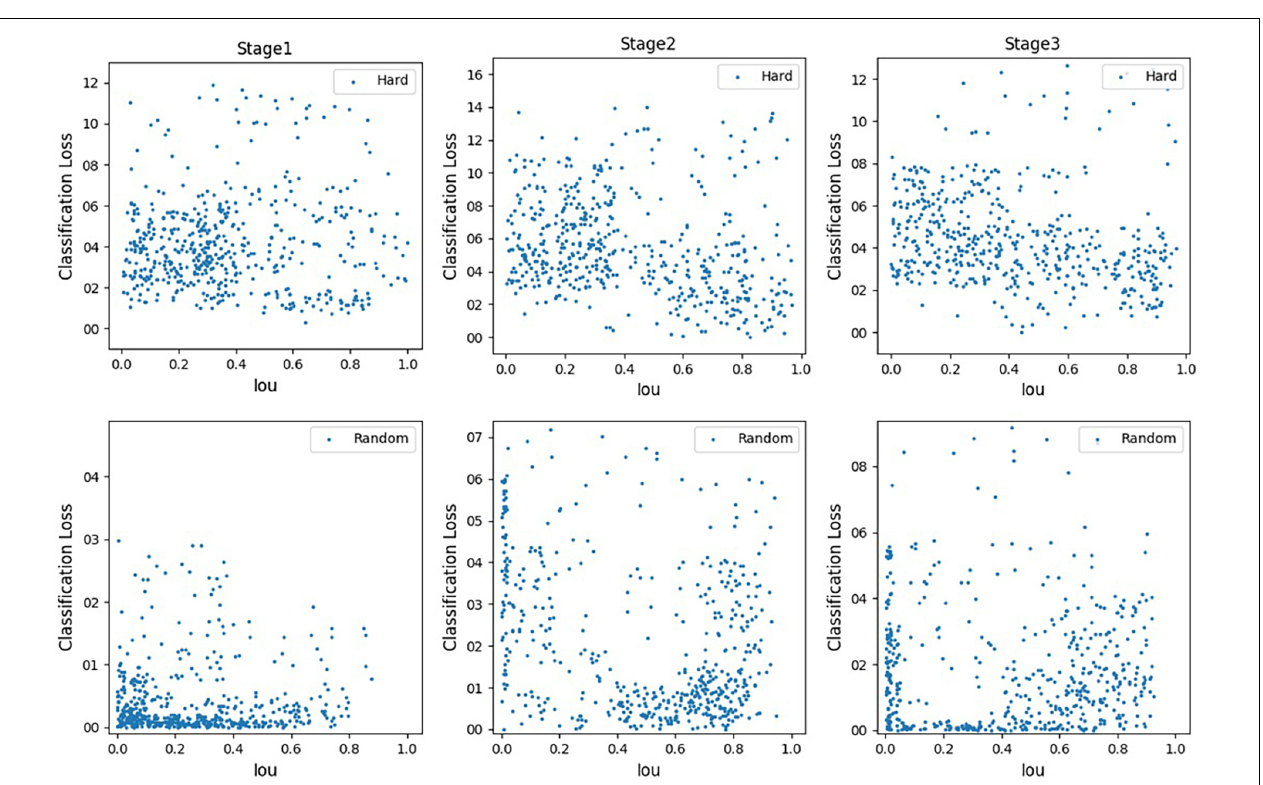
FIGURE 10 | Comparison of difficult sampling and random